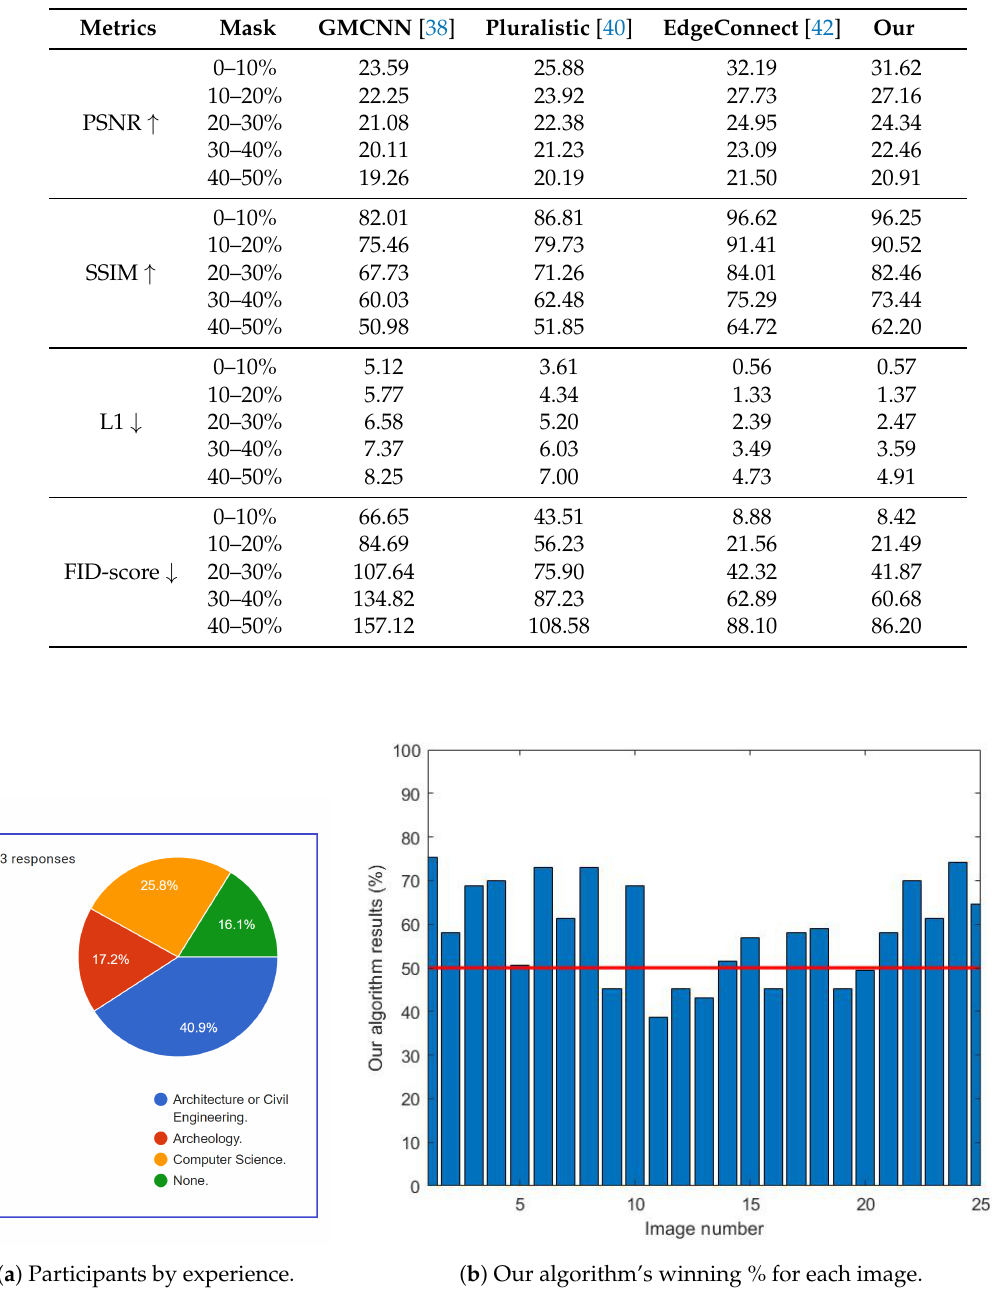
Figure 10. Qualitative comparison results of the EdgeConnect and the proposed method using 25 selected test images. In the survey, 93 people participated with different background (see ( a , b ) shows for each image the percentage of the answers, which marked the proposed algorithm’s output better than EdgeConnect’s